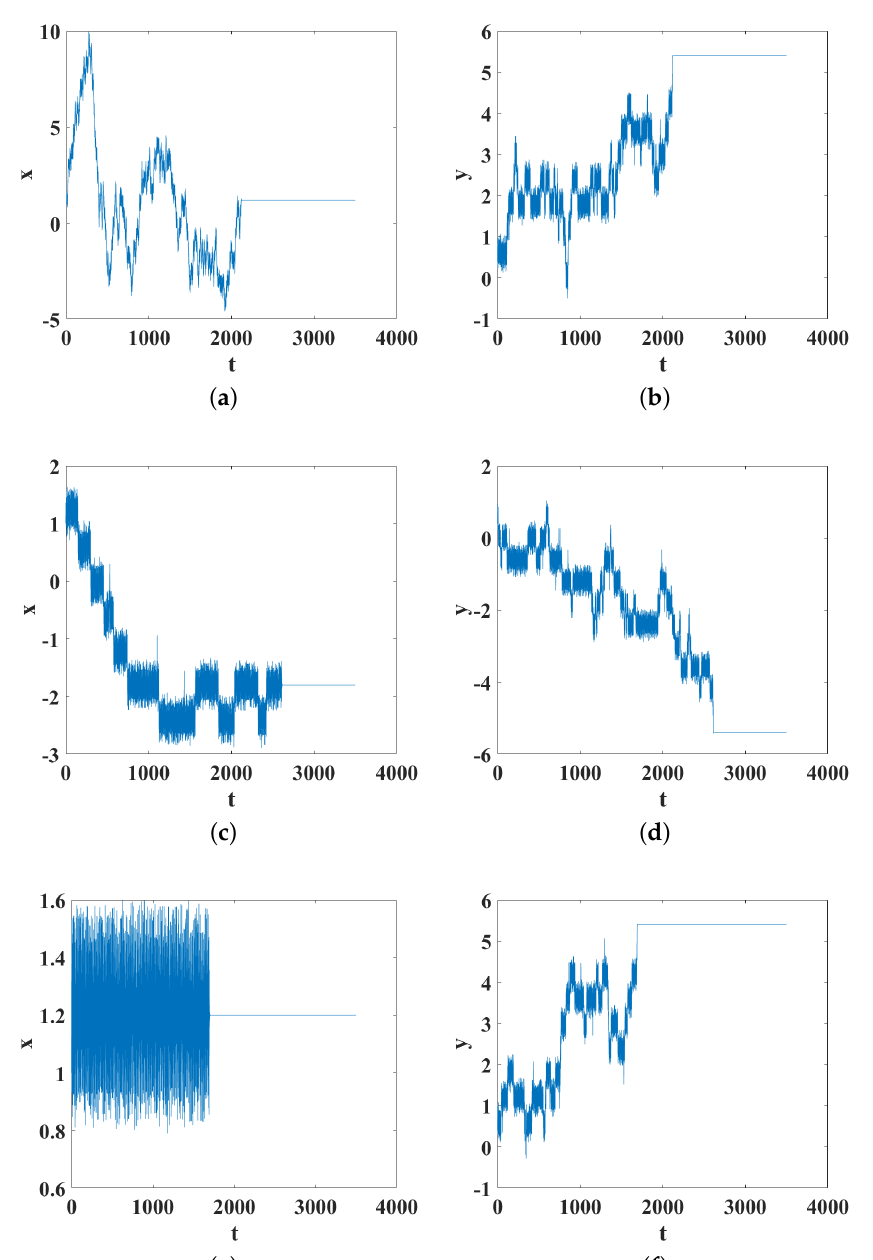
Figure 4. Times of particle settling for different initial conditions and a single value of the dispersion medium size ( m = 8). ( a , b ) k 3 = 0.6; ( c , d ) k 3 = 1.1; ( e , f ) k 3 =